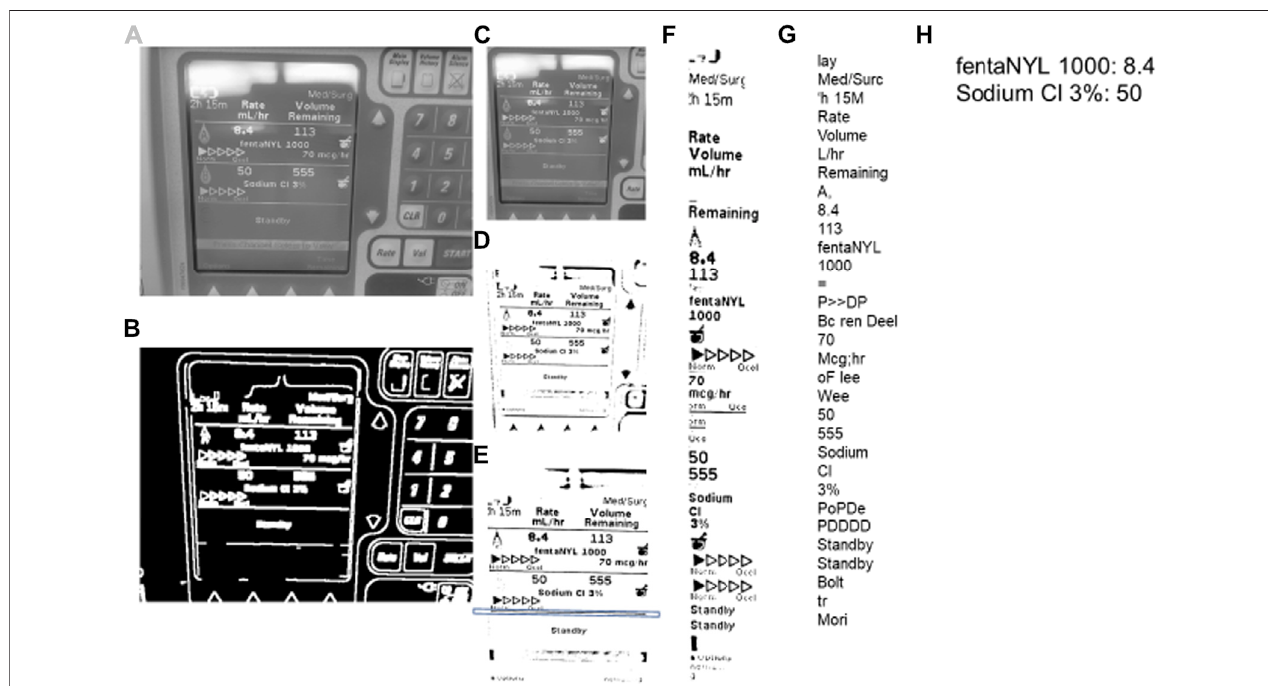
FIGURE 3 | Steps for image processing – TIE and OCR. TIE (cid:1) Text Information Extraction, OCR (cid:1) Optical Character Recognition. The processing proceeds in alphabetical order. (A) is the initial image converted to grayscale. (B) is the grayscaled image processed with the Canny function. (C) is the grayscaled cropped image using the rectangle contours of image (B) . (D) is the adaptive mean threshold function of image (C) . E is the cropped and rotated image (D) with the key horizontal line contained within a box. F is the features found with the google tesseract of image (E) . (G) is the string that Google Tesseract output from image (F) . (H) is the fi nal output of the (G) string